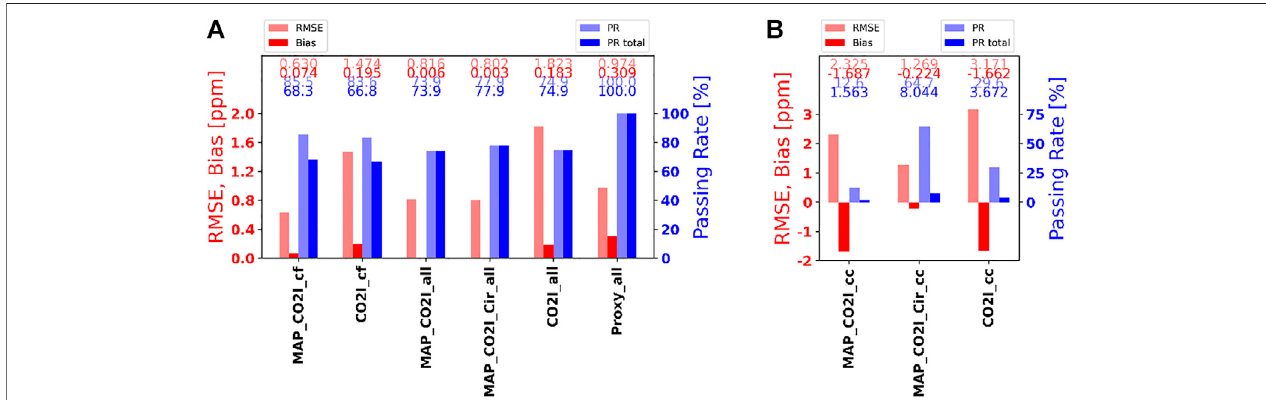
FIGURE 7 | Summary of XCO 2 retrievals for different cases. (A) shows from left to right the performance of not fi tting cirrus in MAP-CO2I and CO2I-only cases on cirrus- fi ltered pixels, not fi tting cirrus in MAP-CO2I case, fi tting cirrus in MAP-CO2I case, and CO2I-only case and proxy retrieval on the whole ensemble. (B) shows not fi tting cirrus in MAP-CO2I case, fi tting cirrus in MAP-CO2I case, and CO2I-only case on true cirrus-contaminated pixels with cirrus mask =